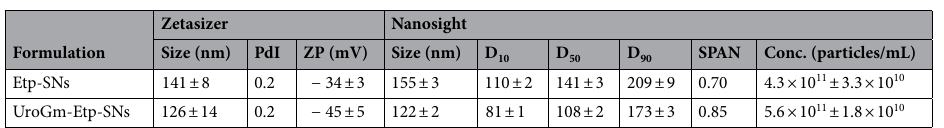
Table 2. Physicochemical characterization of UroGm-Etp-SNs. nm: nanometer, PdI: polydispersity index, ZP: zeta potential in millivolts (mV), SNs: Sphingomyelin nanosystems, Etp: Etoposide, UroGm: Modified Uroguanylin, (mean ± SD; n ≥